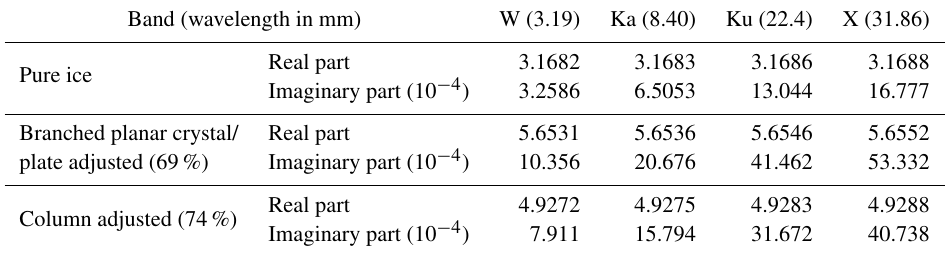
Table 1. Dielectric constants at 0 ◦ C for W-, Ka-, Ku-, and X-band wavelengths of pure ice and of the tiny spheres used in the representations of the plates, branched planar crystals, and columns after compensating for the air